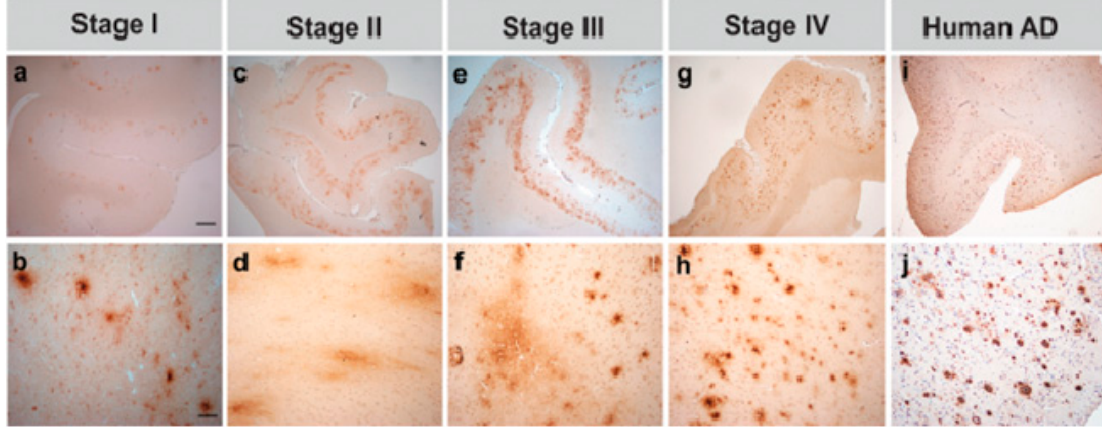
Figure 6. Photomicrographs exemplifying the four stages of amyloid beta (A β 1-16) deposition in aged canines’ prefrontal cortex. ( a , b ) Stage I—very few small plaques with poorly defined borders. ( c , d ) Stage II—abundant, cloud-like plaques in the deep cortical layers. ( e , f ) Stage III—abundant, cloud-like plaques in the deep cortical layers and small, distinct plaques in facile layers. ( g , h ) Stage IV—meager, condensed plaques found in all cortical layers, except layer I. ( i , j ) Immunoreactivity of amyloid plaques in human’s frontal cortex (patient with Alzheimer’s disease). Bars = 1000 μ m in